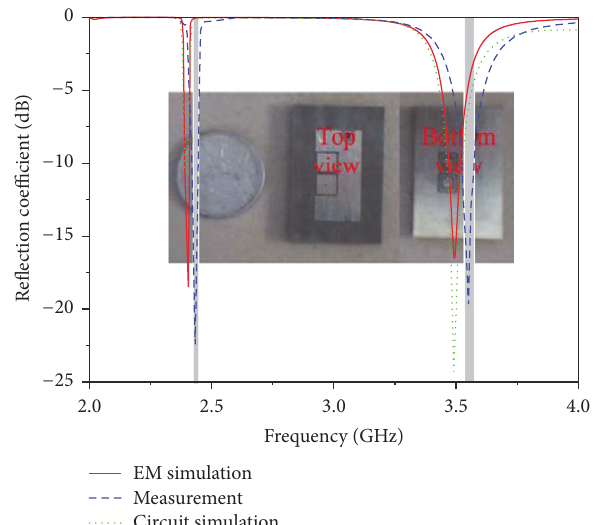
Figure 10: Simulated and measured return loss with the photograph of antenna displayed in the inset. The shadow represents the − 10dB bandwidth of the proposed